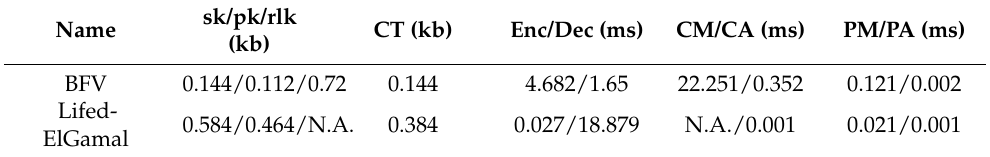
Table 3. Comparison of the efficiency and bandwidth of the basic operations between the BFV scheme and Lifed-ElGamal scheme protocol. Lifed-ElGamal has no relinearization key and does not support multiplication between ciphertexts. We set “N.A.” for this case. The column “CT” is the bandwidth of the ciphertext. The column “CM/CA” is the runtime for multiplication and addition between ciphertexts. The column “PM/PA” is the time for multiplication and addition between ciphertext and